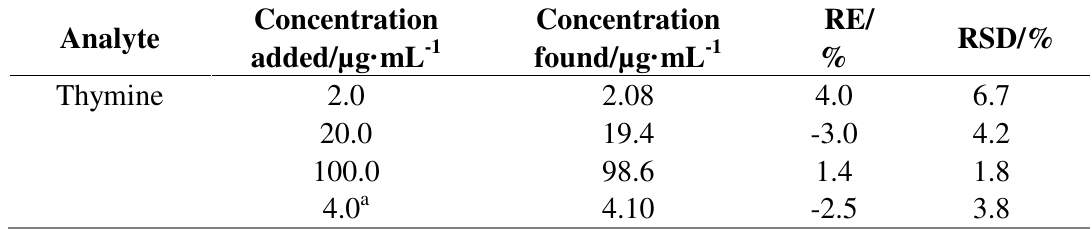
Table 4. Inter-assay precision and accuracy of thymine, adenine, adenosine and